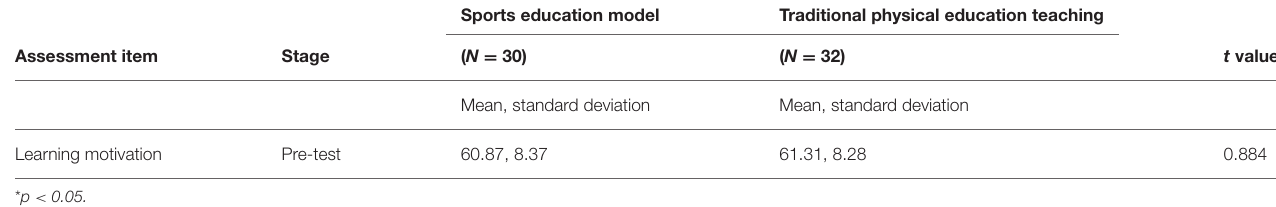
TABLE 3 | Comparison of the two groups: pre-test learning motivation effect t-test.